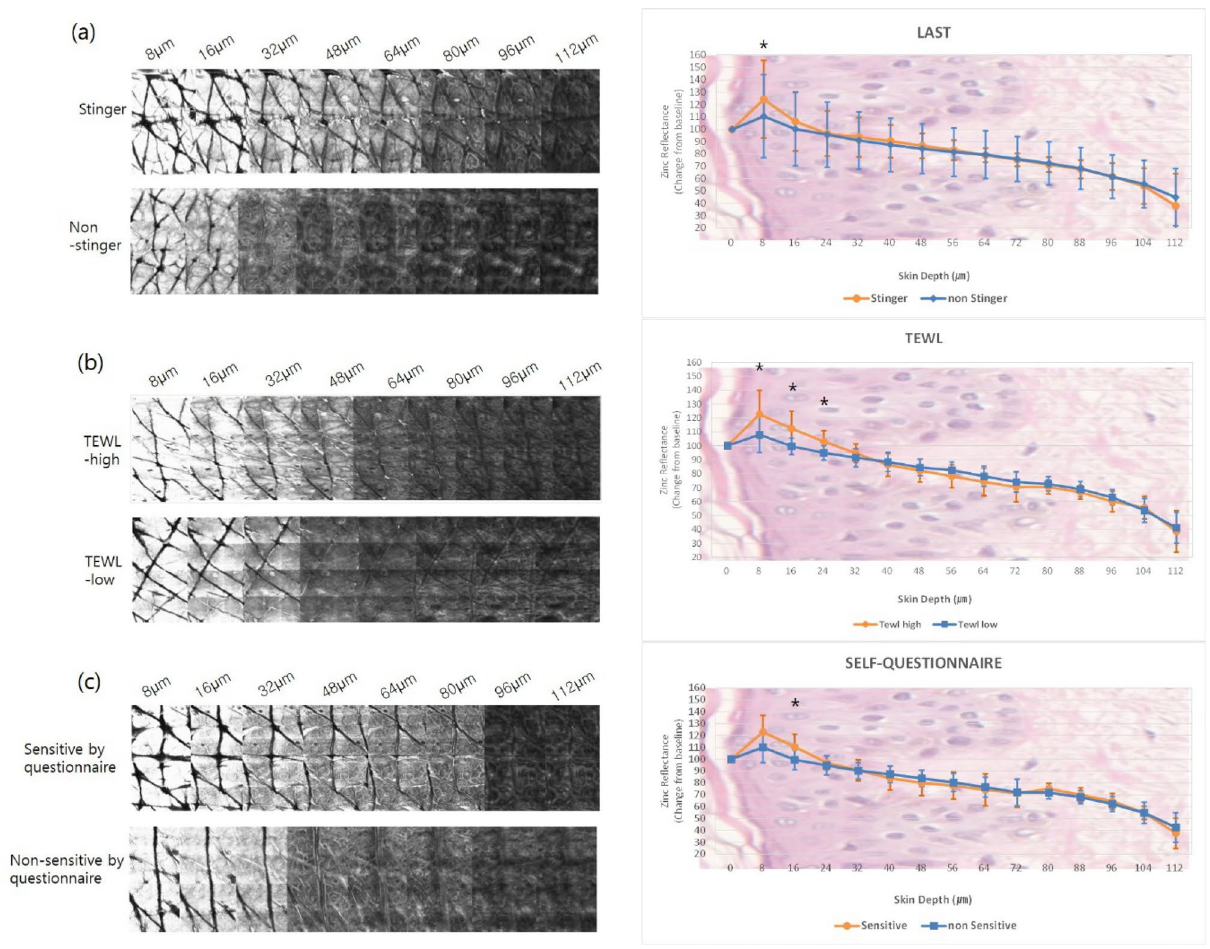
Figure 2. RCM images and the zinc reflectance values on the forearm. The reflectance intensity of zinc at 8 µm in the ‘stinger’ group was greater than the in ‘non-stinger’ group ( P = 0.004) ( a ). The high-TEWL group showed greater zinc reflectance from 8 μm to 24 μm depth on the forearm ( P = 0.009 at 8 μm, P < 0.001 at 16 μm, P = 0.001 at 24 μm) ( b ). There was a significant difference at the 16 μm depth ( P = 0.003) in subjects self- identifying as having ‘sensitive’ skin compared to ‘non-sensitive’ skin ( c ). (* P <